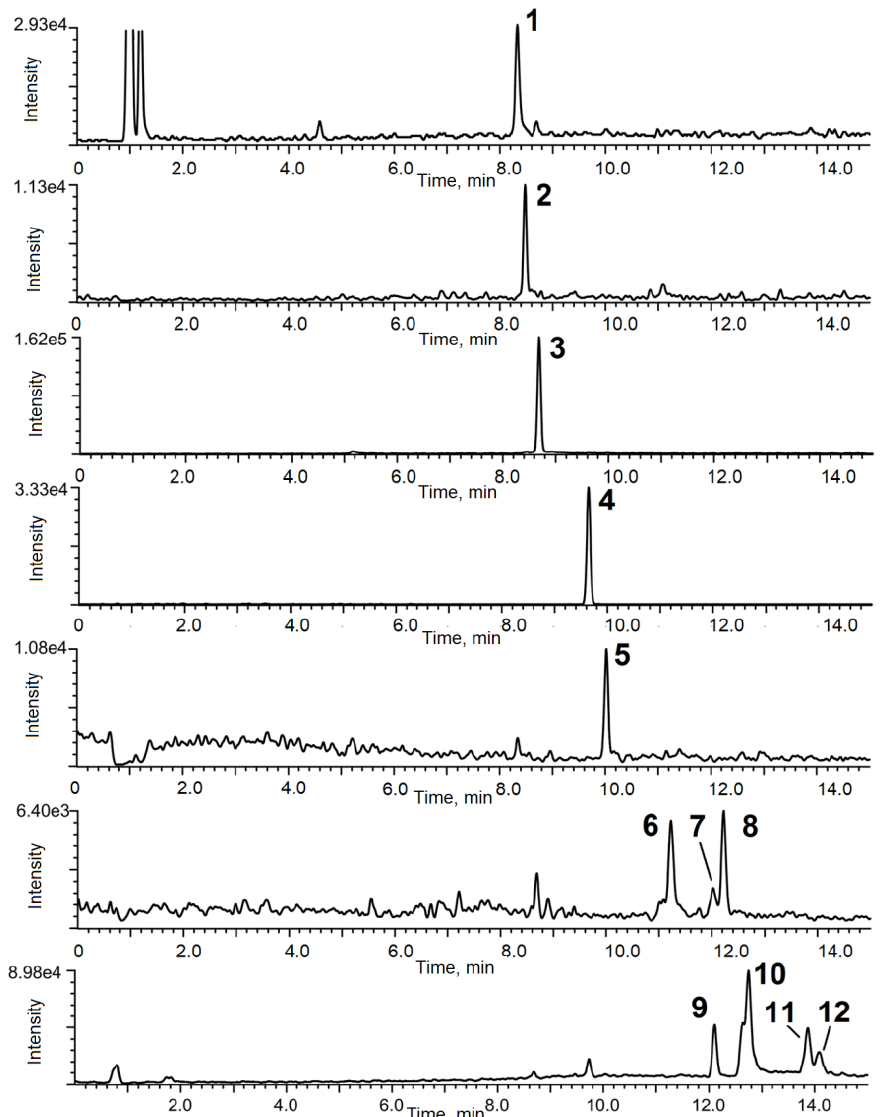
Figure 4. Chromatograms of a deep gas storage aquifer water sample. 1—salicylic acid,